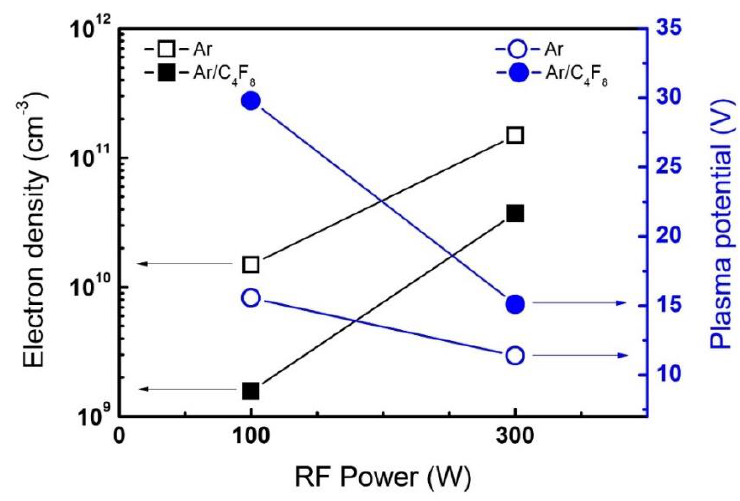
Figure 5. Changes in electron density and plasma potential with an increase in RF power from 100 W to 300 W in Ar and Ar/C 4 F 8 plasma.